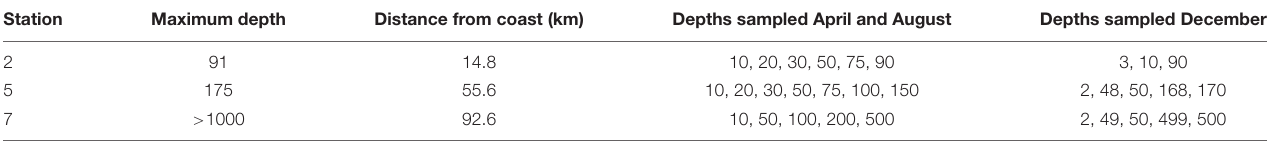
TABLE 1 | Water depths sampled for DOM during 2015 off Callao.